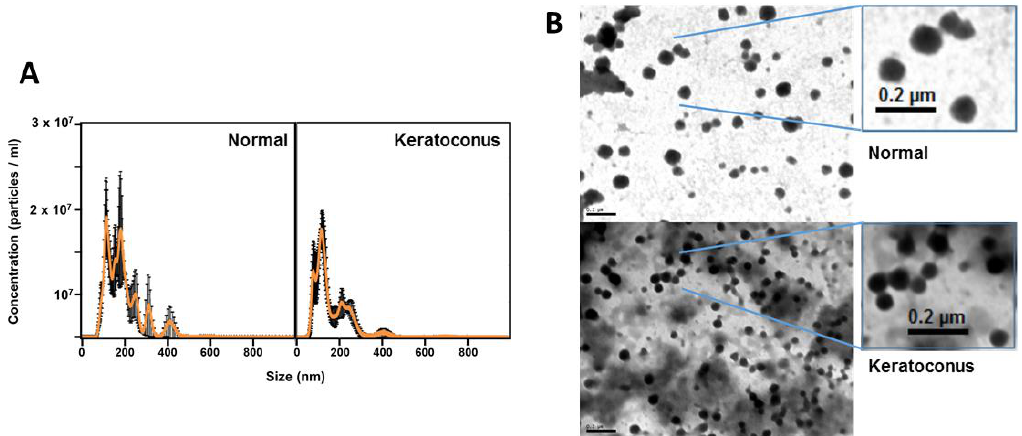
Figure 1. Characterization of normal- and KC corneal stromal cell derived extracellular vesicles. ( A ) Size distribution of vesicles determined by NanoSight LM10; left: normal stromal cells, right: keratoconic cells. ( B ) TEM images of exosomes from normal stromal cells (upper panel) and KC stromal cells (bottom panel).